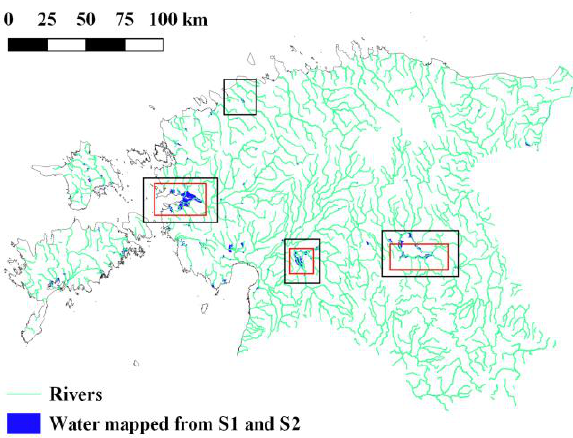
Figure 6. Statistical flood extent map from Sentinel-1 and Sentinel-2